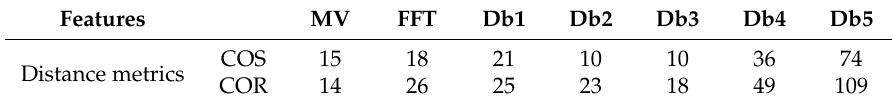
Table 7. Optimal numbers of different features after selection for Dataset I.